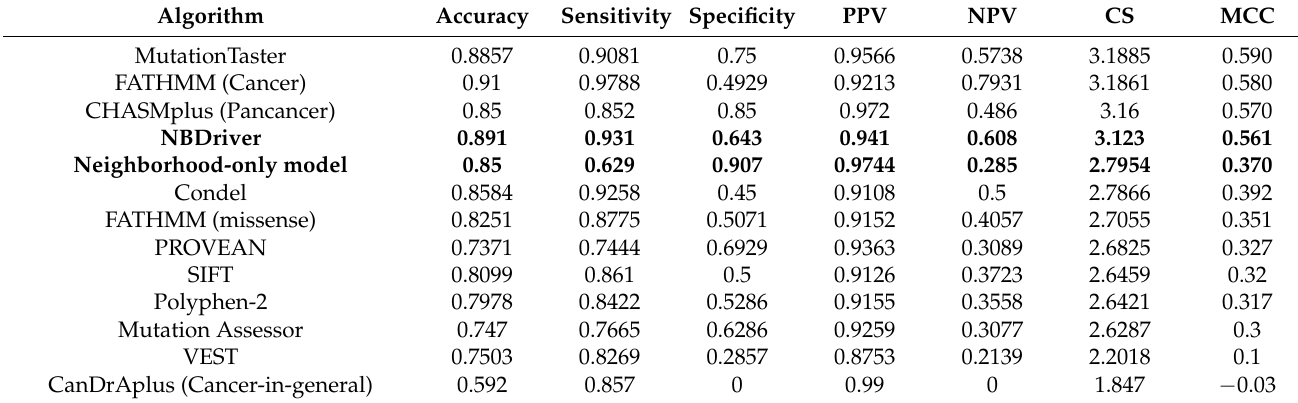
Table 2. Comparison of the generated binary classifiers with other mutation effect prediction algorithms using the benchmarking dataset published by Martelotto et al. (Ranked in decreasing order on the basis of the composite score or CS).